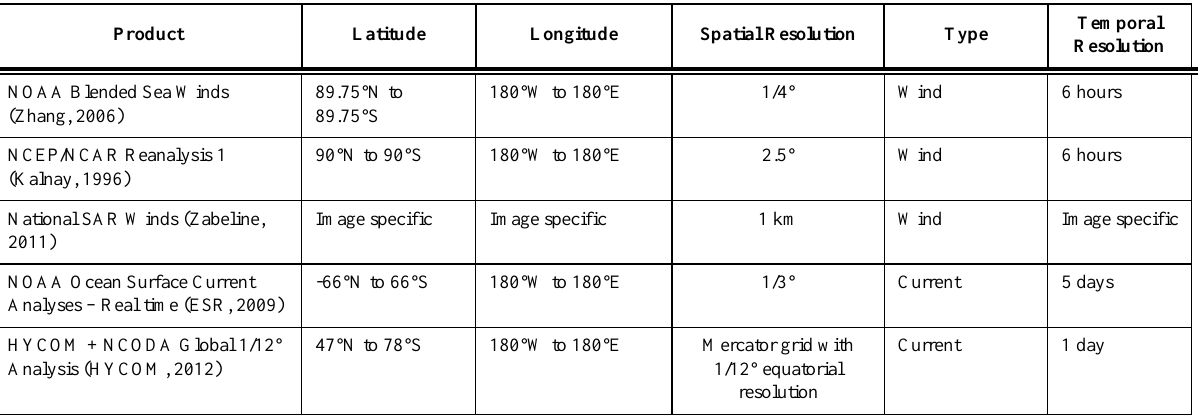
Table 1. Environmental Data